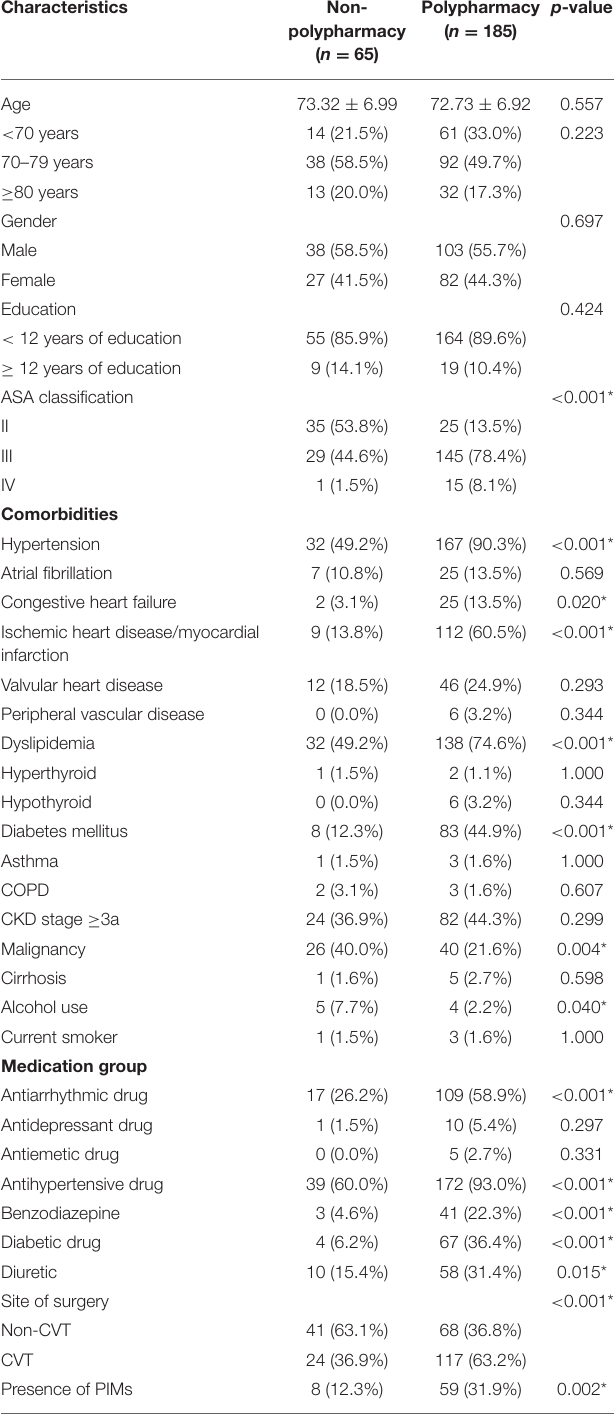
TABLE 2 | Preoperative characteristics compared between the non-polypharmacy and polypharmacy groups. Characteristics